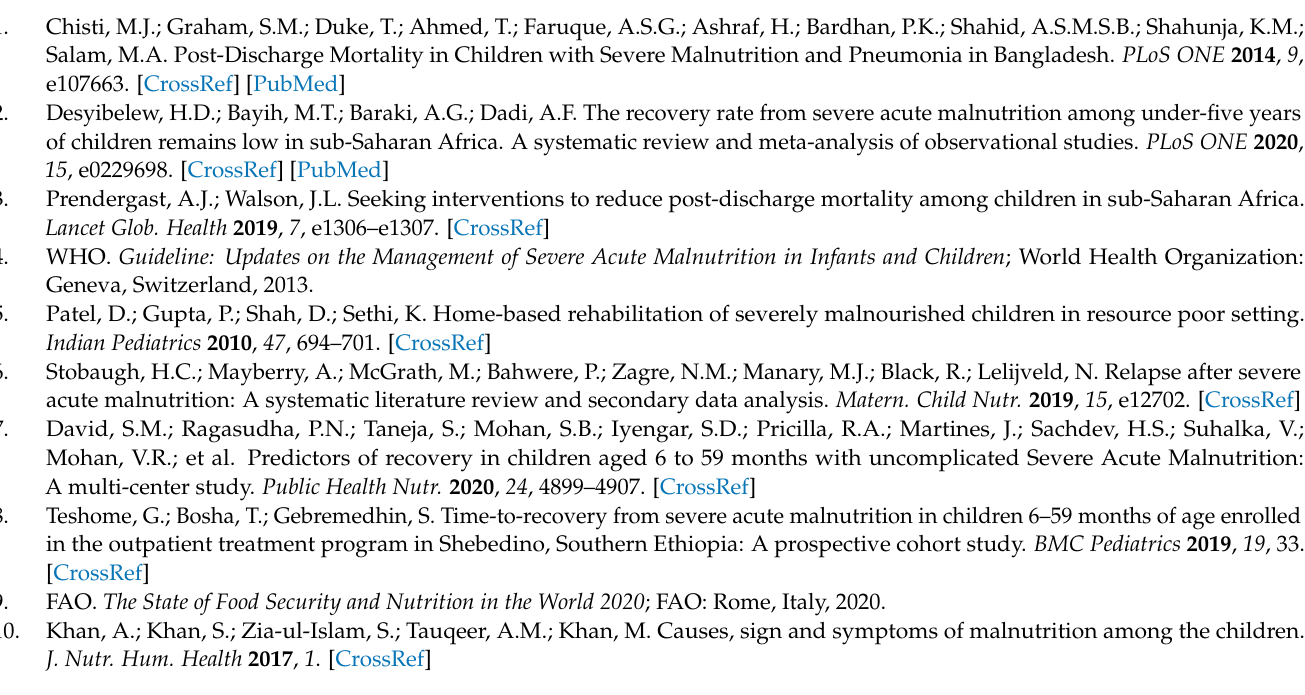
individuals with a follow-up MUAC and without a follow-up MUAC, Table S8: The distribution of specific food groups by breastfeeding status, Table S9: The relationship of wealth quintiles with breastfeeding status, Table S10: The distribution of specific food groups, food insecurity, dietary diversity, and study setting by fruits and vegetables, Table S11: The distribution of food security and dietary diversity by study site, Table S12: The distribution food types by study site, Table S13: Proportion of recovery by facility, Table S14: Kaplan Meier test result comparing time to recovery acrsso stusy sites, Table S15: Crude HR for the association of study site with